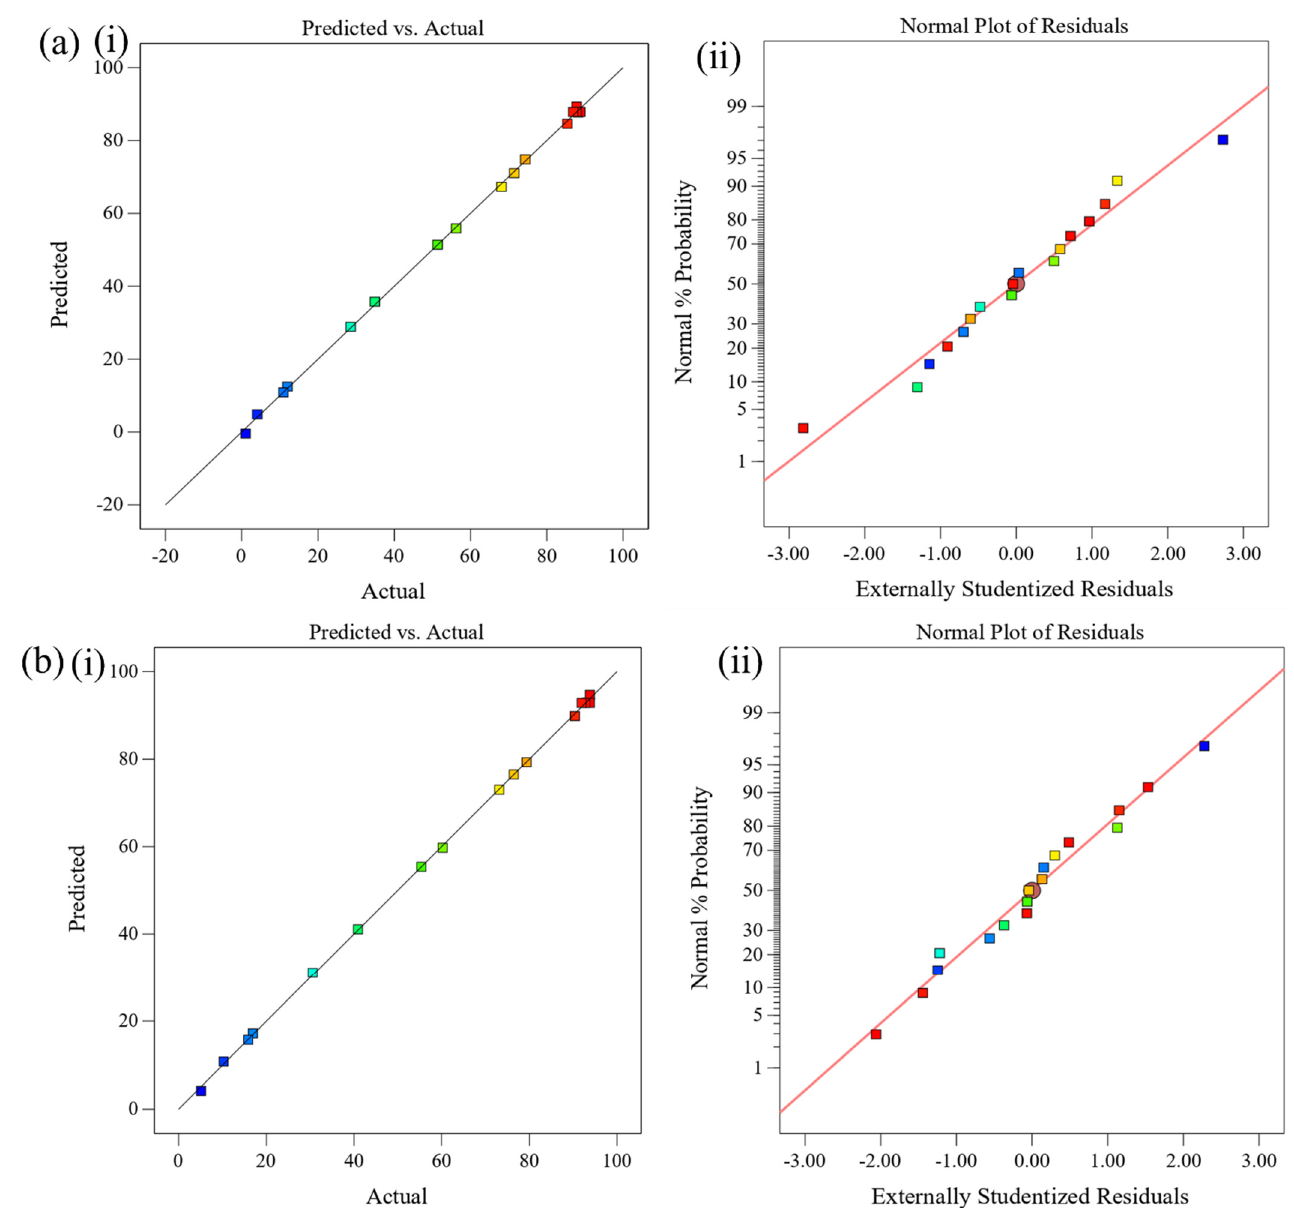
Figure 6. ( a ) ( i ) Predicted vs. actual ( ii ) normal probability plot values for the photodegradation of BPB and ( b ) ( i ) predicted vs. actual ( ii ) normal probability plot values for the photodegradation of RhB.